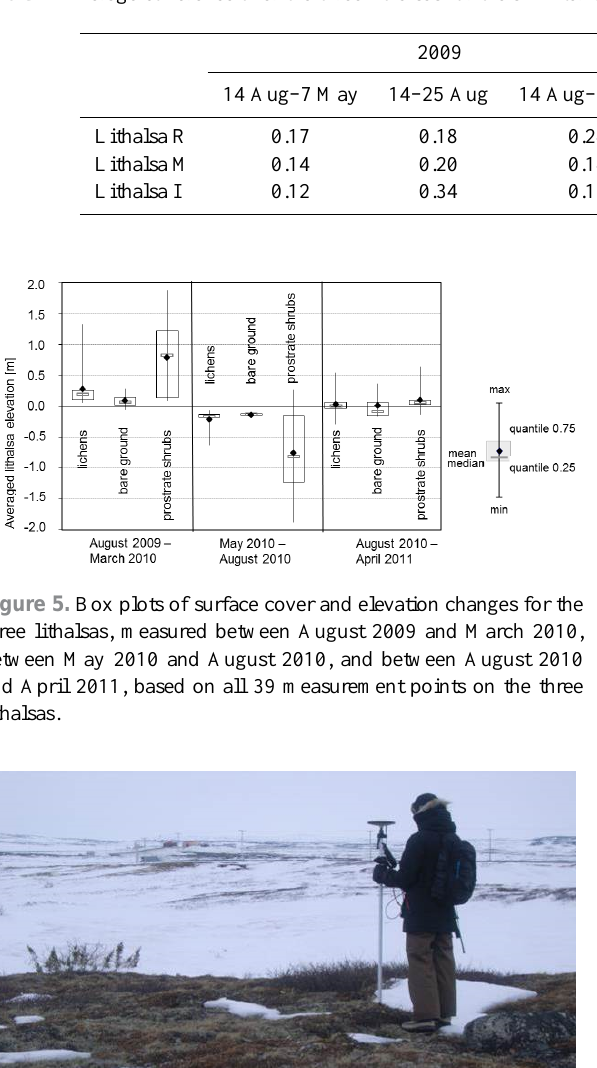
Figure 7. The six interferograms (A: 14 August–7 May 2009; B: 14–25 August 2009; C: 14 August–30 October 2009; D: 12 August–5 May 2010; E: 12–23 August 2010; and F: 12 August–28 October 2010). Left: broad area around Umiu- jaq, northern Quebec, Canada. The dashed arrow to the north of Umiujaq indicates the fringes of slow movements; the dotted circle indicates the area of signals to the east of the lithalsas. Right: area covering the three lithalsas of interest; the amount of movement ex- ceeds the amount that can be quantified with TerraSAR-X